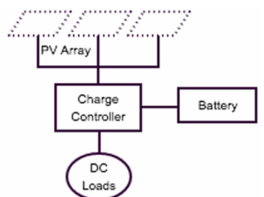
Figure 2. Stand-alone Photovoltaic System connection.